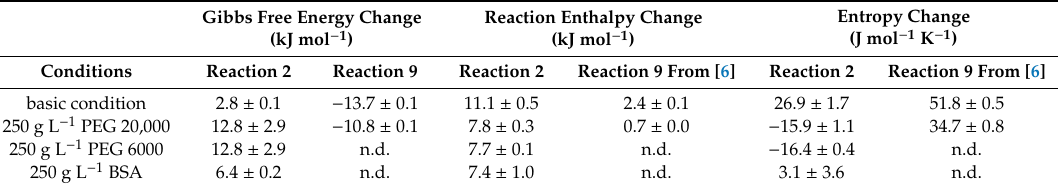
Table 2. Entropy change values for both reactions with di ff erent crowding agents. Results for reaction 9 are from [6]. The indicated errors are from the triplicate measurements or the maximum error. The conditions not determined are marked with